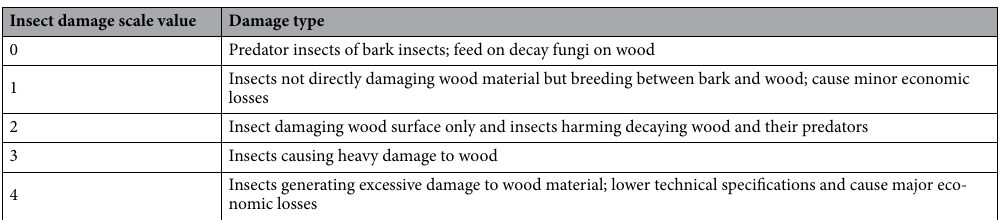
Table 2. Insect damage scale values according to damage